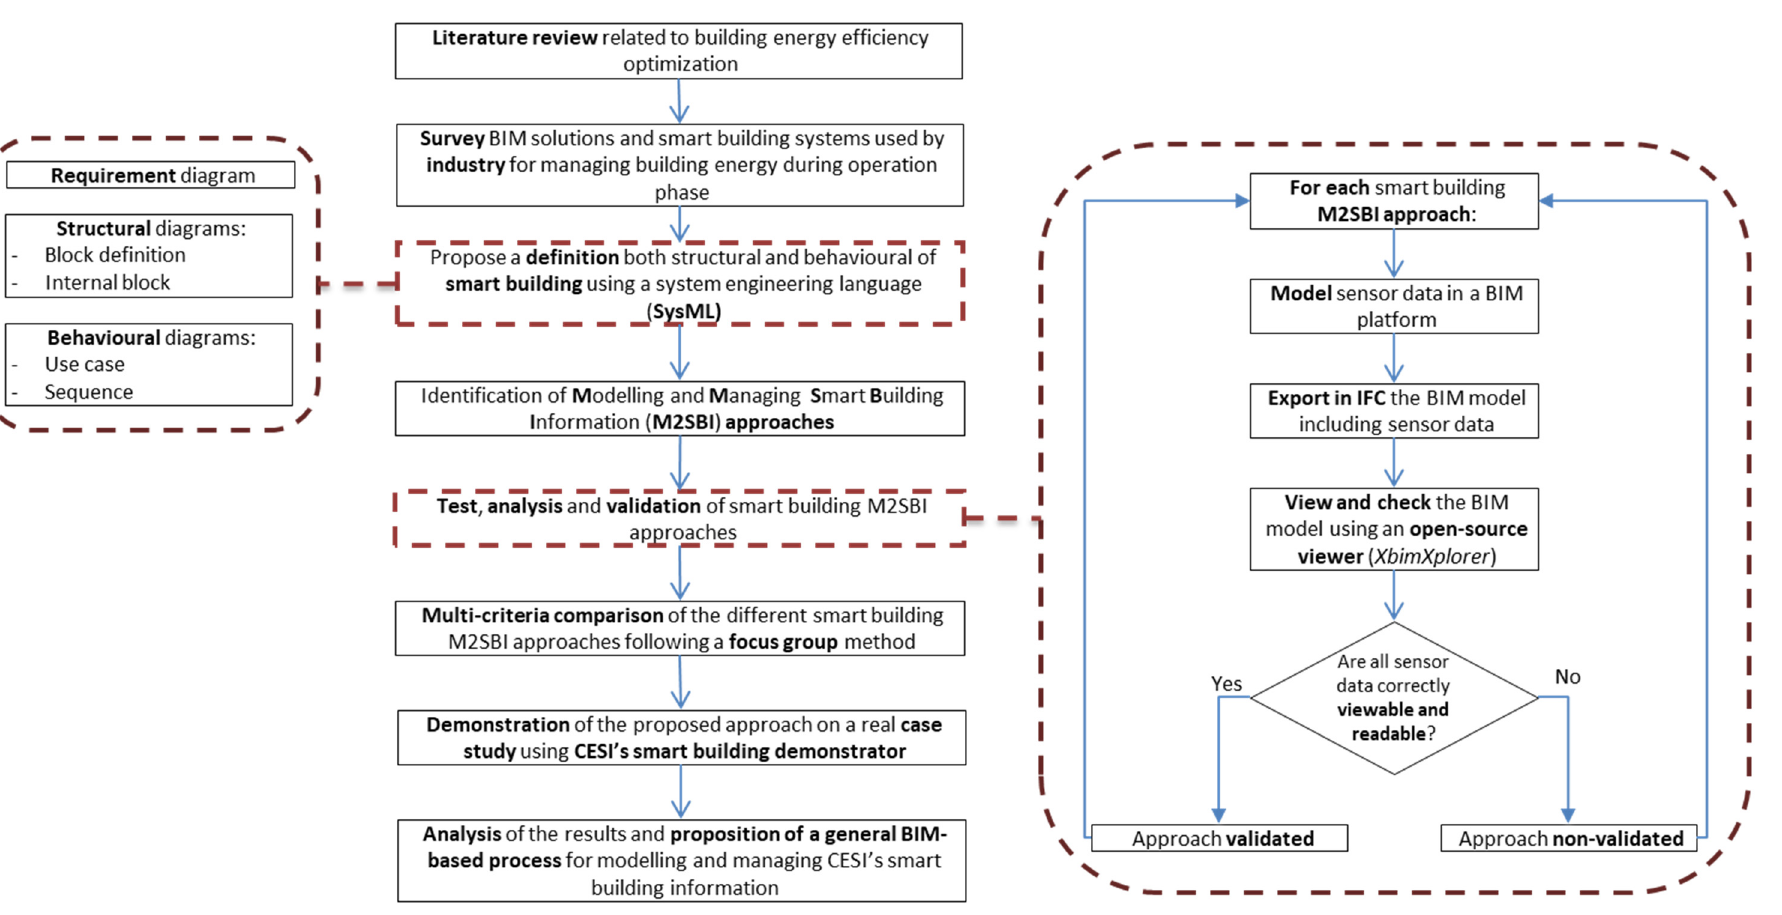
Figure 1. Research methods.